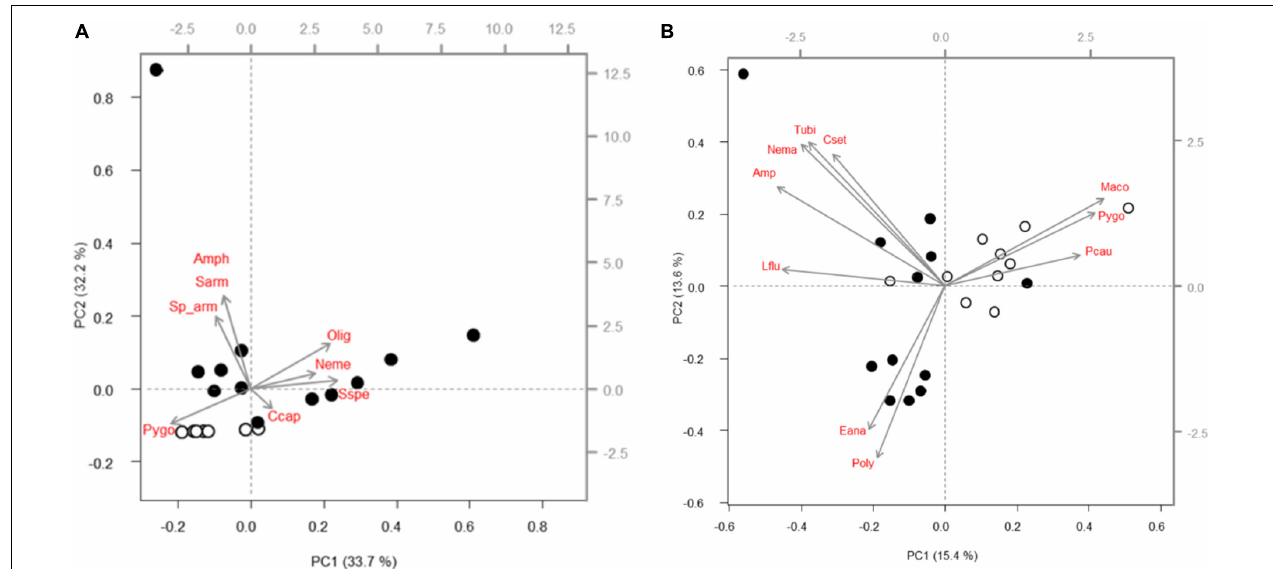
FIGURE 7 | Biplots showing two principal components (= black axes) explaining 65.9% (Logyearbyen) and 29% (Thiisbukta) of the total variation in Bray-Curtis similarity of relative taxon abundances between communities sampled in unmanipulated areas prior to (white dots) and at the end of the experiments (black dots) in Longyearbyen (A) and Thiisbukta (B) . Loading values (= gray axes) of up to 10 taxa most strongly affected by seaweed temporally. Gray arrows = loading vectors for separate taxa (red font: Amph, amphipods; Ccap, Capitella capitata ; Cset, Chaetozone setosa ; Eana, Euchone analis ; Lflu, Liocyma fluctuosa ; Maco, Macoma sp.; Nema, nematodes; Neme, Nemertea; Olig, oligochaetes; Poly, polychaetes; Pcau, Priapulus caudatus ; Pygo, Pygospio sp.; Sarm, Scoloplos armiger ; Sp_arm, Spio armata ; Sspe, Spio sp.; Tubi,